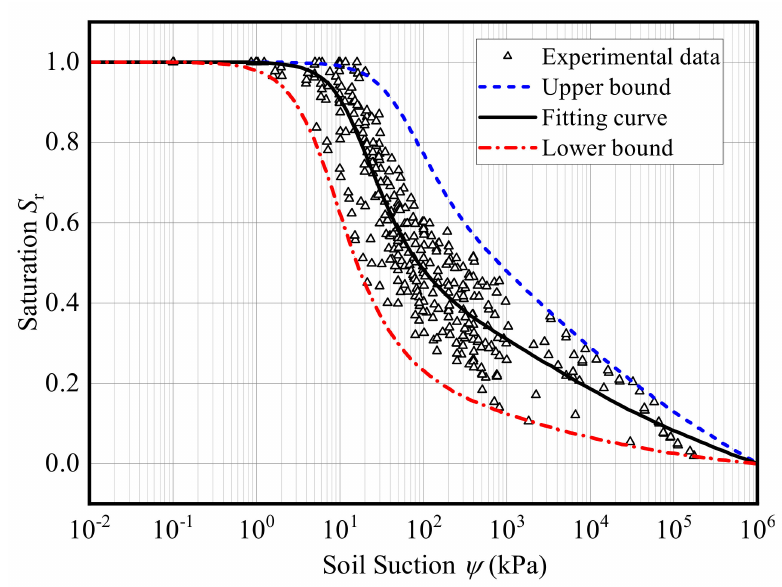
Figure 1. Illustration of best-fitted SWCC, upper and lower bounds for the loess.